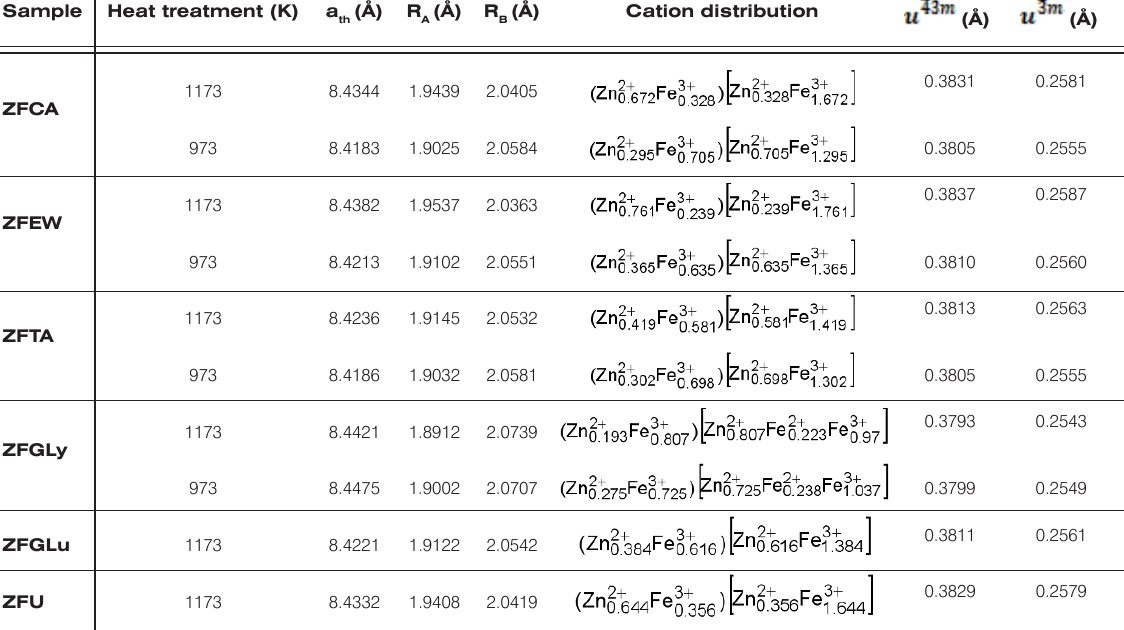
Table 5. Theoretical lattice parameter ( a ZF samples. Sample Heat treatment